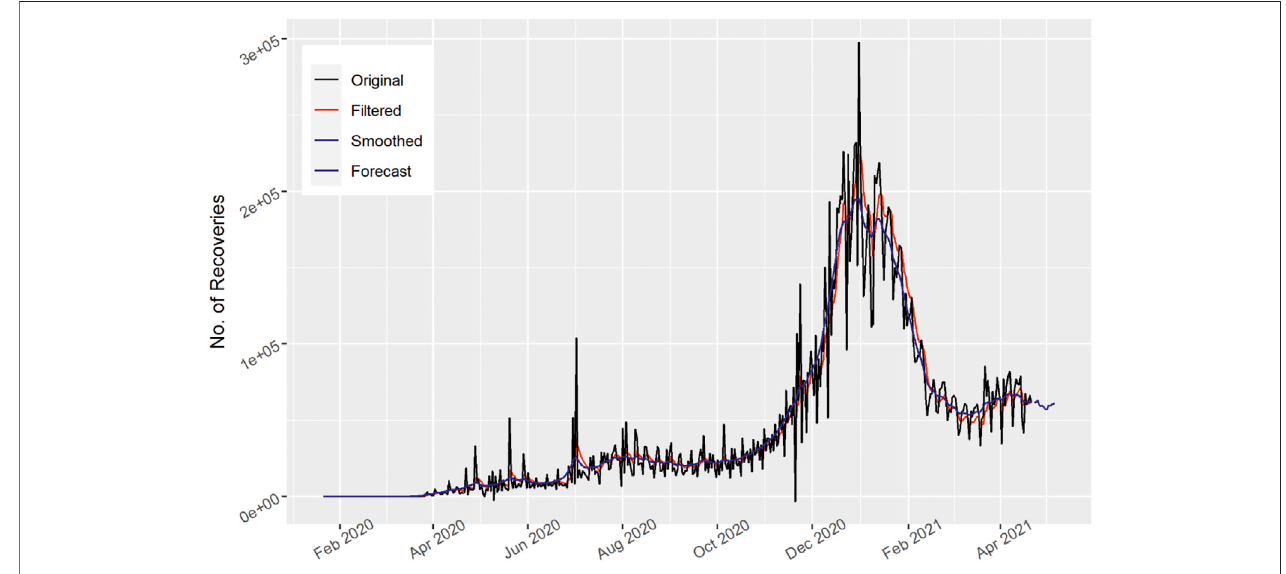
FIGURE 9 | Number of daily recovered cases of the United States.